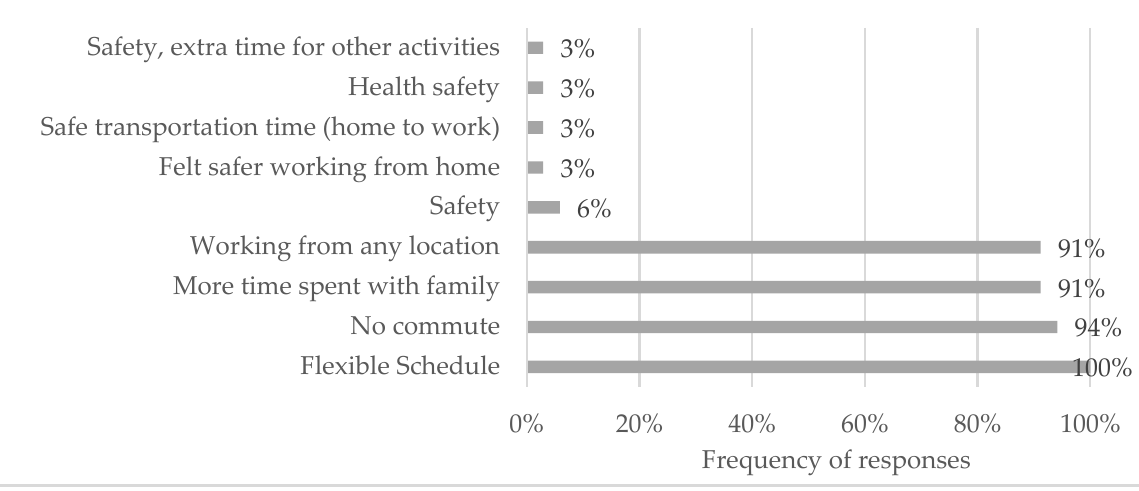
Figure 4. Relative frequency distribution of responses to “Top benefits of remote work”.